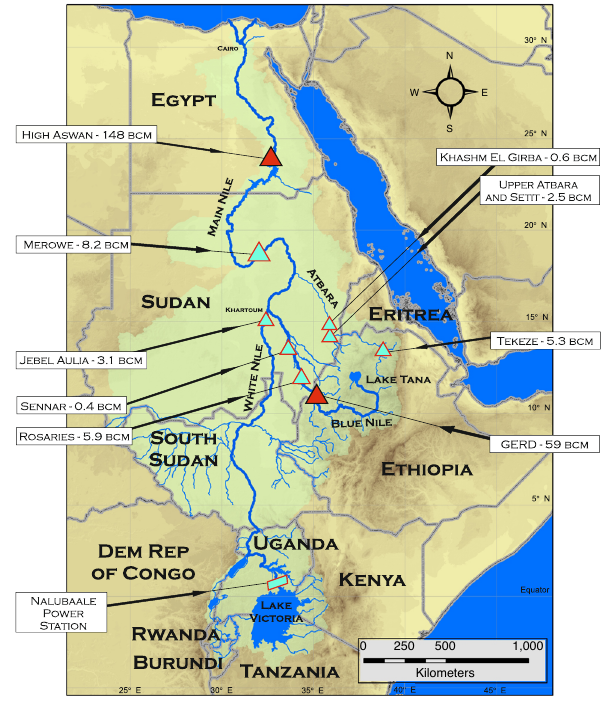
Fig. 1 Map of the Nile Basin with major infrastructure. Active reservoir storage volumes are shown for each location.